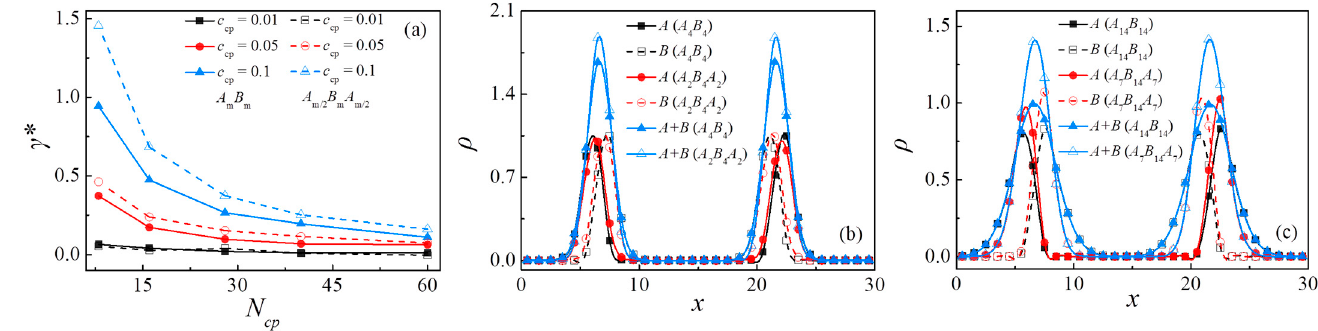
Figure 3. ( a ) Reduced interfacial tension γ ∗ = γ 0 − γ of blends as a function of copolymer chain length at copolymer concentration of c cp = 0.01, 0.05, 0.1. Density profiles of beads A , B, and A + B of copolymer along the x -axis at ( b ) N cp = 8 ( c ) N cp = 28, where c cp = 0.1.